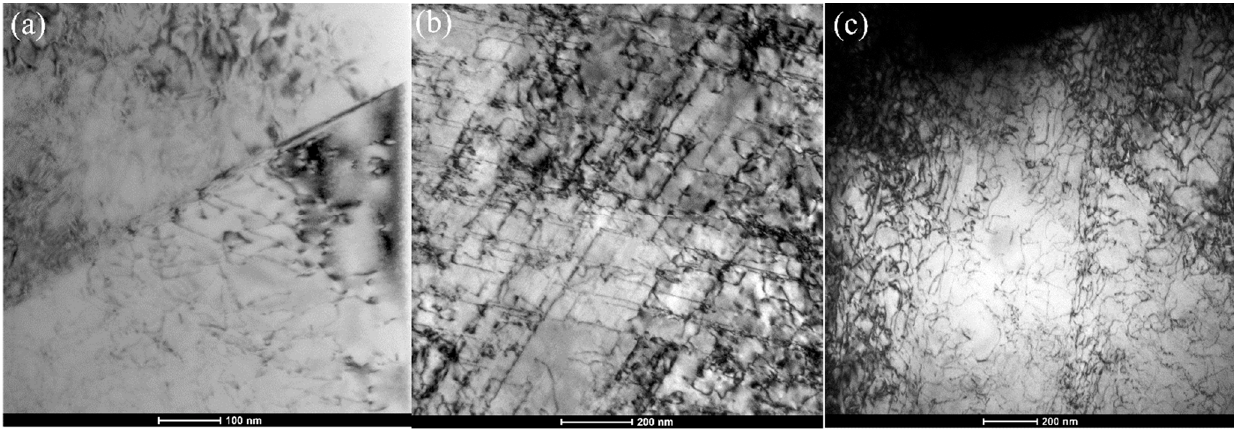
Figure 7. The dislocations in ( a ) UT, ( b ) 5-TC-UT, and ( c ) 10-TC-UT specimens.